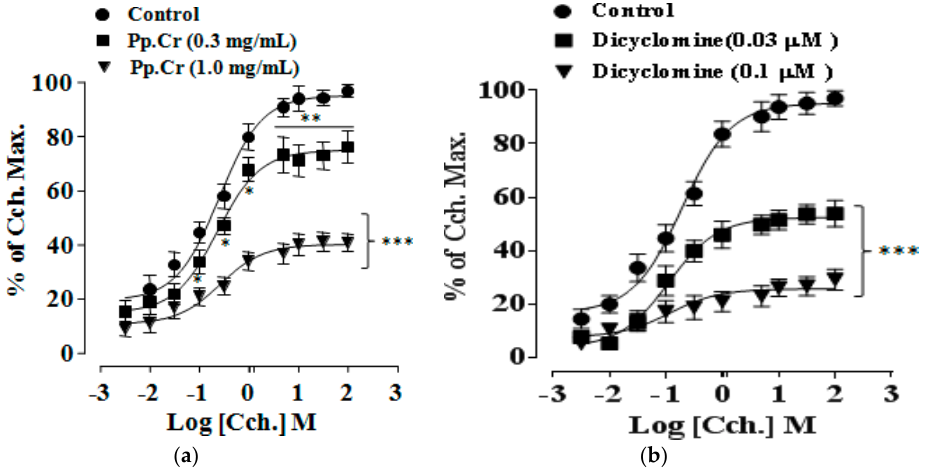
Figure 6. CRCs of Cch in the absence and presence of increasing concentration of Pp.Cr (mg/mL) ( a ) and dicyclomine ( µ M) ( b ) on rabbit trachea preparations. * p < 0.05, ** p < 0.01, and *** p < 0.001 compared to the respective control. (Mean ± SEM, n =